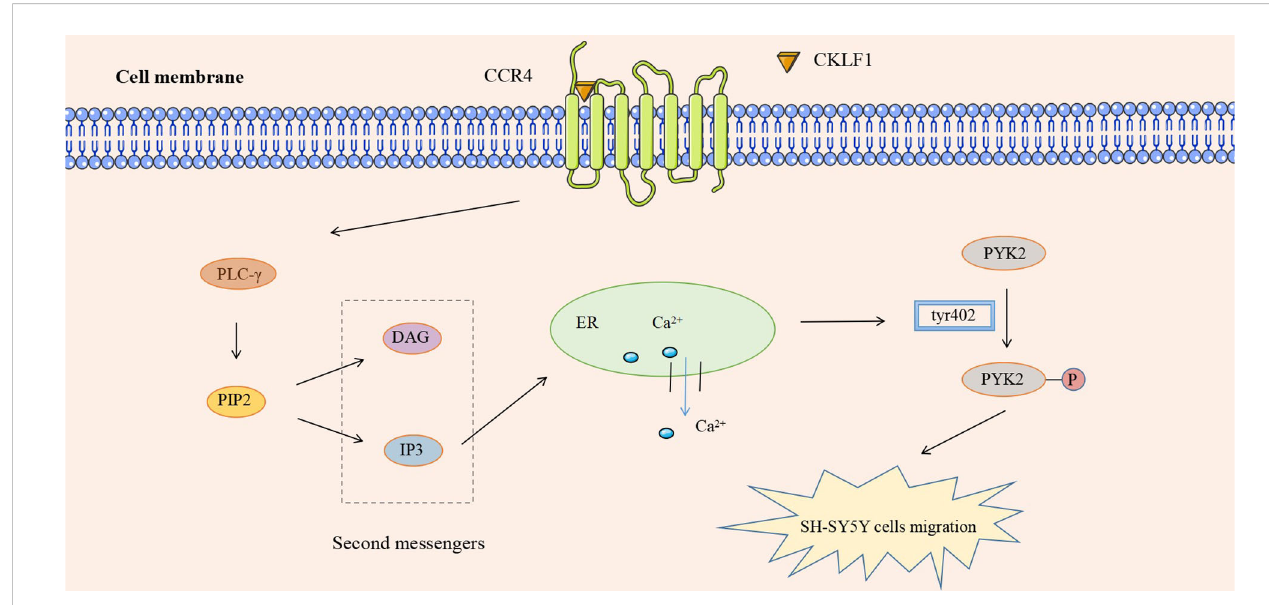
FIGURE 5 CKLF1 binds to CCR4 and induces the release of stored Ca2+ through the PYK2 pathway, activates autophosphorylation at the PYK2-tyr402 site, and regulates the migration of SH-SY5Y cells.